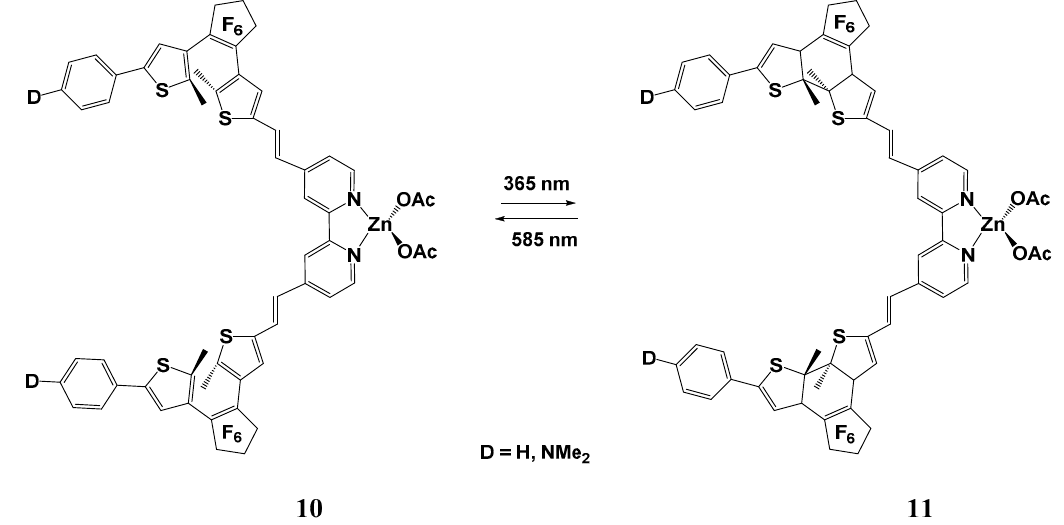
Figure 2. Zn(II) bipyridine complexes with a photoswitchable second ‐ order NLO ‐ response; Ac =